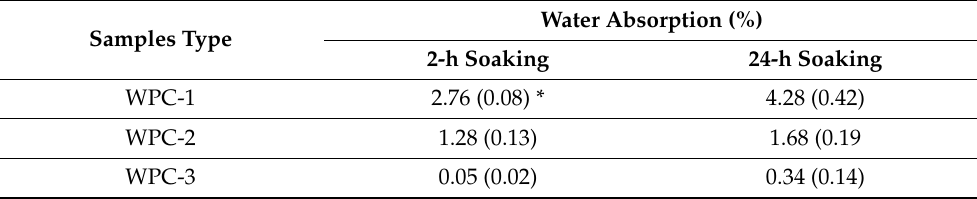
Table 3. Water absorption values of the samples.